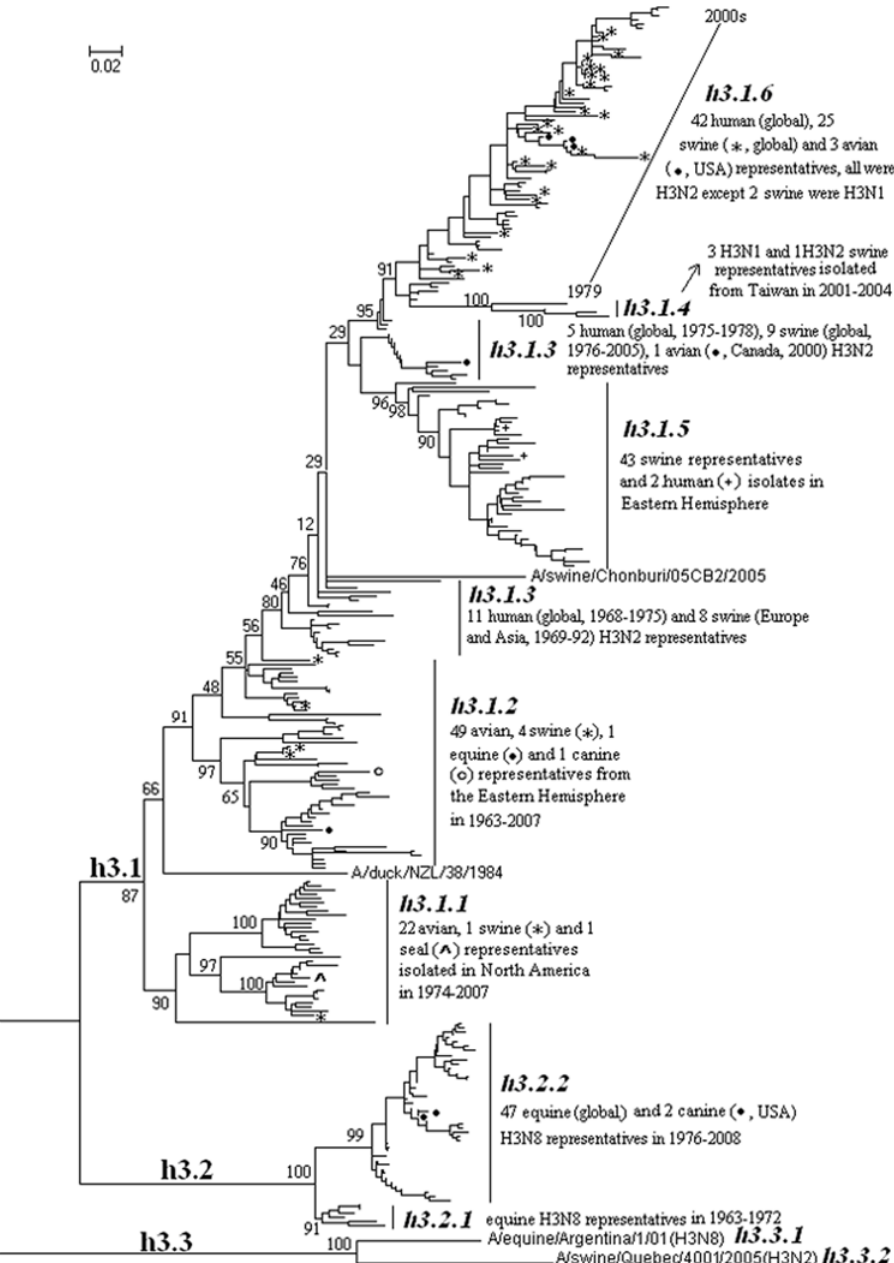
Figure 5. The panorama phylogenetic tree of subtype H3 influenza virus based on the viral HA sequences. Bootstrap values were given at relevant nodes.